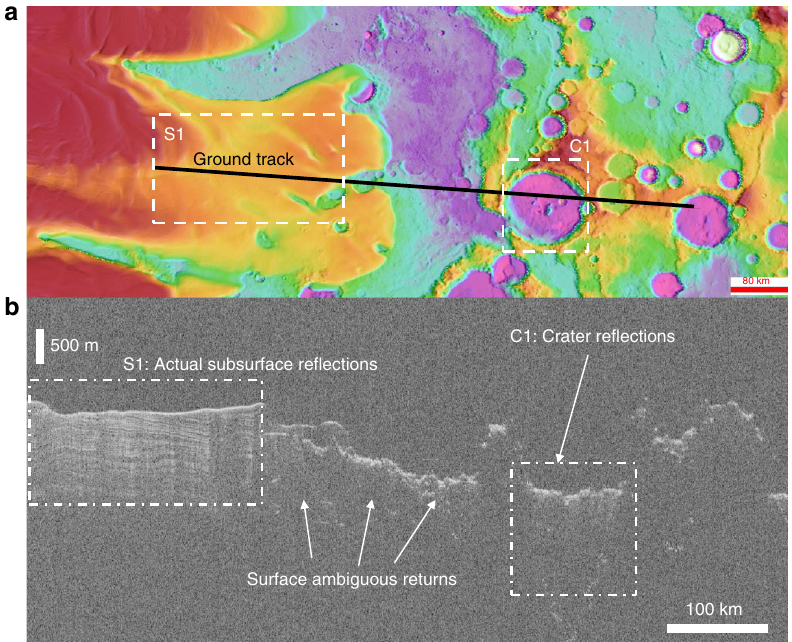
Fig. 2 Data interpretation ambiguities due to clutter. a Ground track of the SHallow RADar 2 acquisition 241301 projected over Mars South Pole region of Promethei Lingula. S1 represents a region where the instrument detects the subsurface-layered deposits, while C1 is an example of ambiguous return due to off-nadir re fl ections from the crater rim. b SHARAD radargram of acquisition 241301. From the image, we can notice that there are many ambiguous returns, which cause dif fi culties in the data